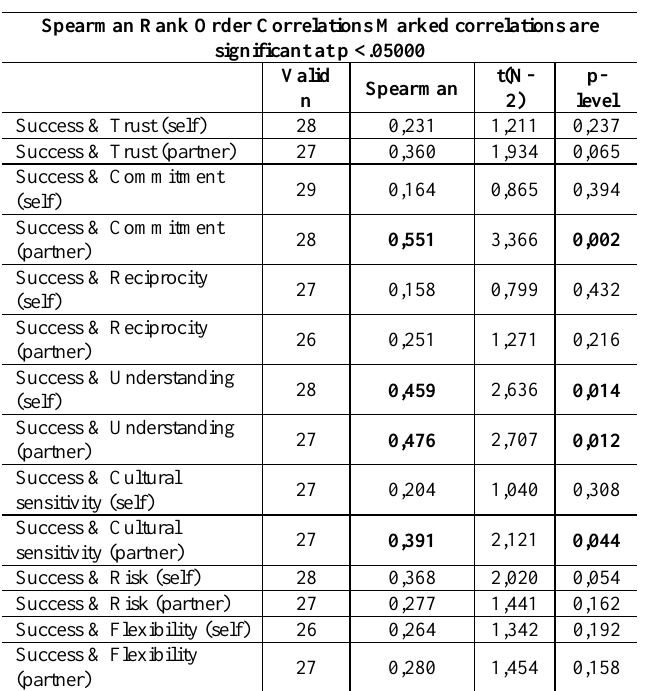
Table 3: Positive attitude and alliance success (individual scores)